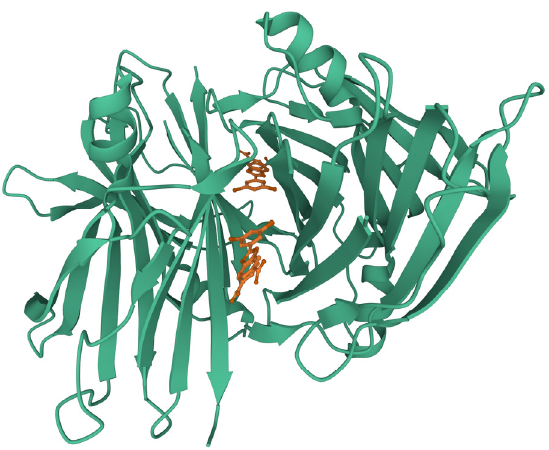
Figure 9. Complex of tafamidis with transthyretin tetramer. PDB ID: 3TCT.